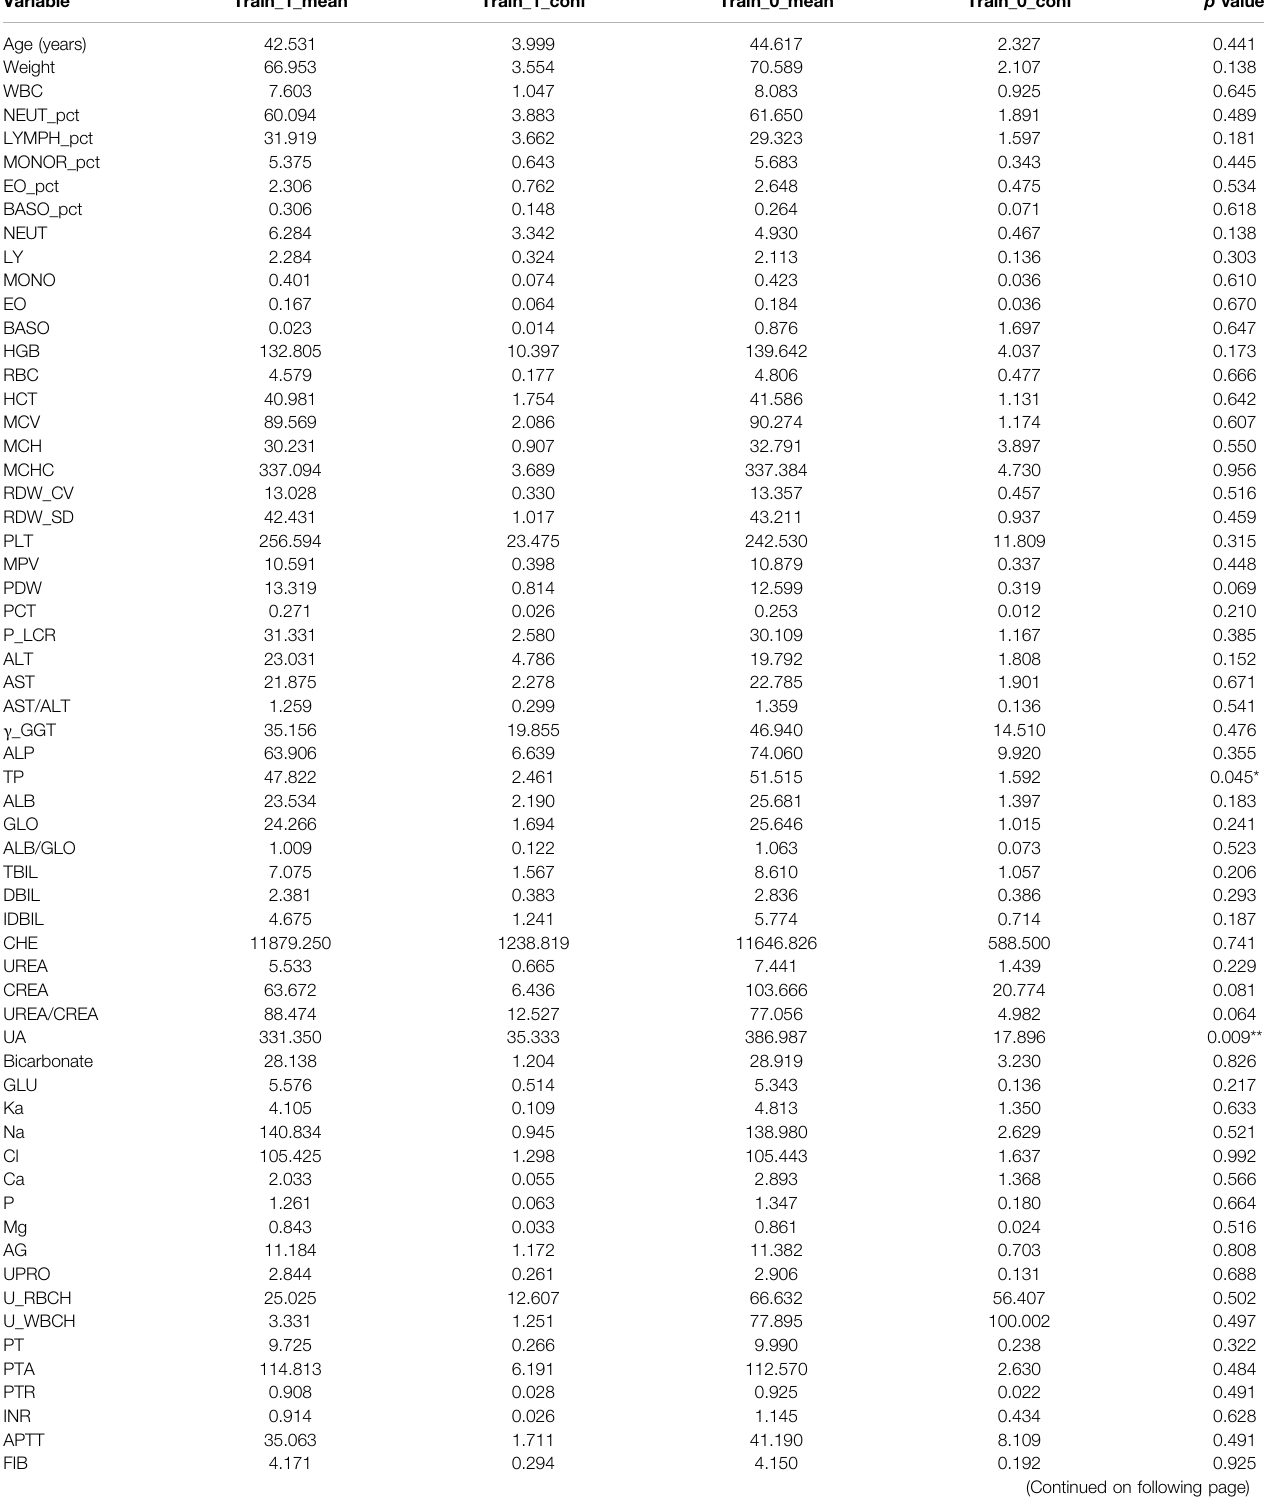
TABLE 1 | Demographic and clinical data before normalization in tremor (Train_1) and non-tremor (Train_0) patients of the training data set. Variable Train_1_mean p value Age